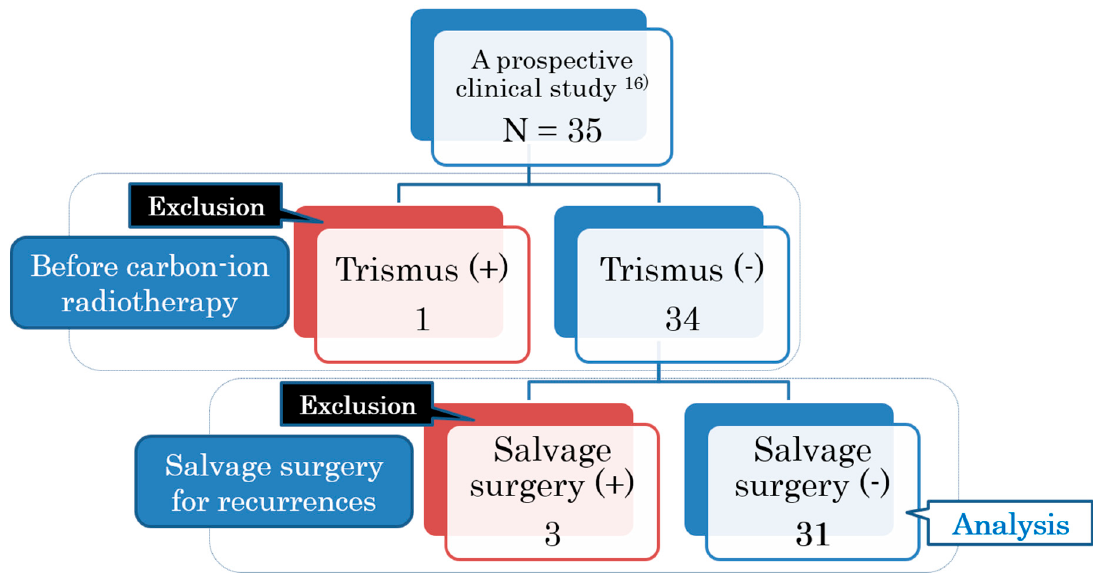
Figure 5. Patient selection criteria for the study. Table 3. Patient and tumor characteristics.